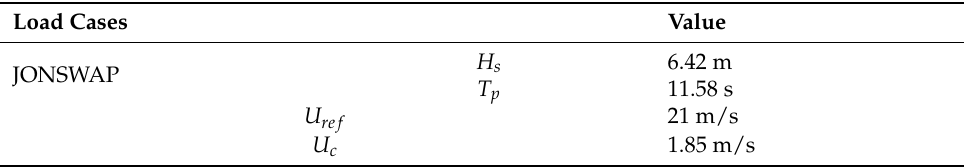
Table 4. Environmental parameters of floating wind